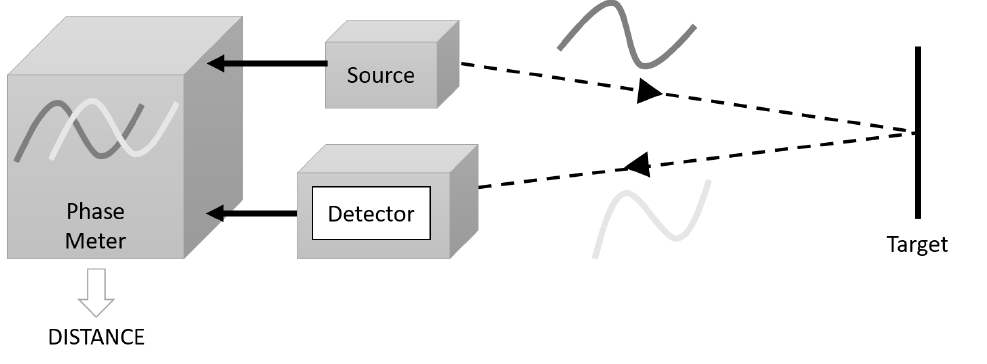
Figure 2. TOF phase-measurement principle used in amplitude modulation of a continuous wave (AMCW)